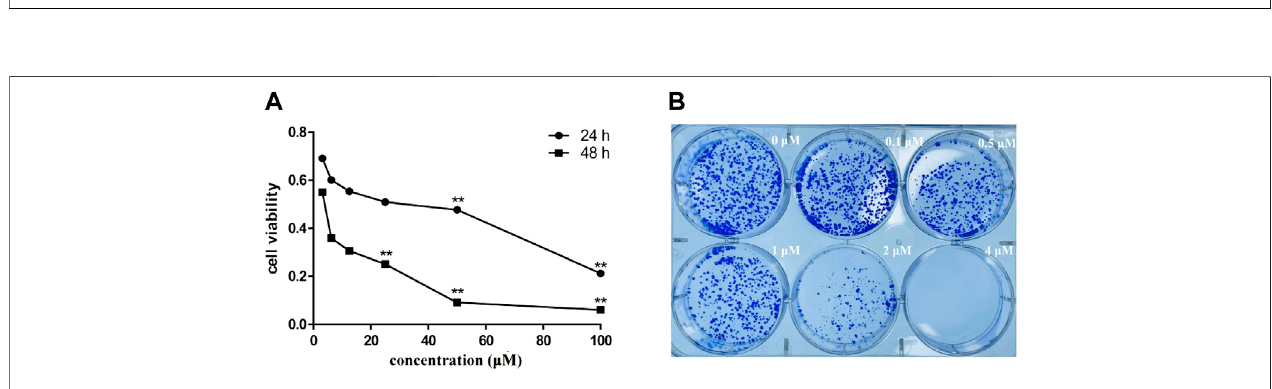
FIGURE 10 | Apoptosis induced by siragrosvenin D in MCF-7 cells detected by the annexin V-FITC/PI staining test. MCF-7 cells were treated with siragrosvenin D (0, 5, 10, and 20 μ M) for 24 h. (A) Apoptotic rates were determined by annexin V-FITC/PI staining. Apoptosis rate was reported as the percentage of apoptotic cells (AV+/PI − and AV+/PI+) among total cells. (B) Data were presented as the mean ± SD ( n = 3). ** p < 0.01.